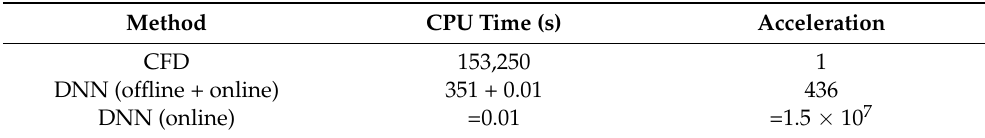
Table 3. Comparison of CPU time